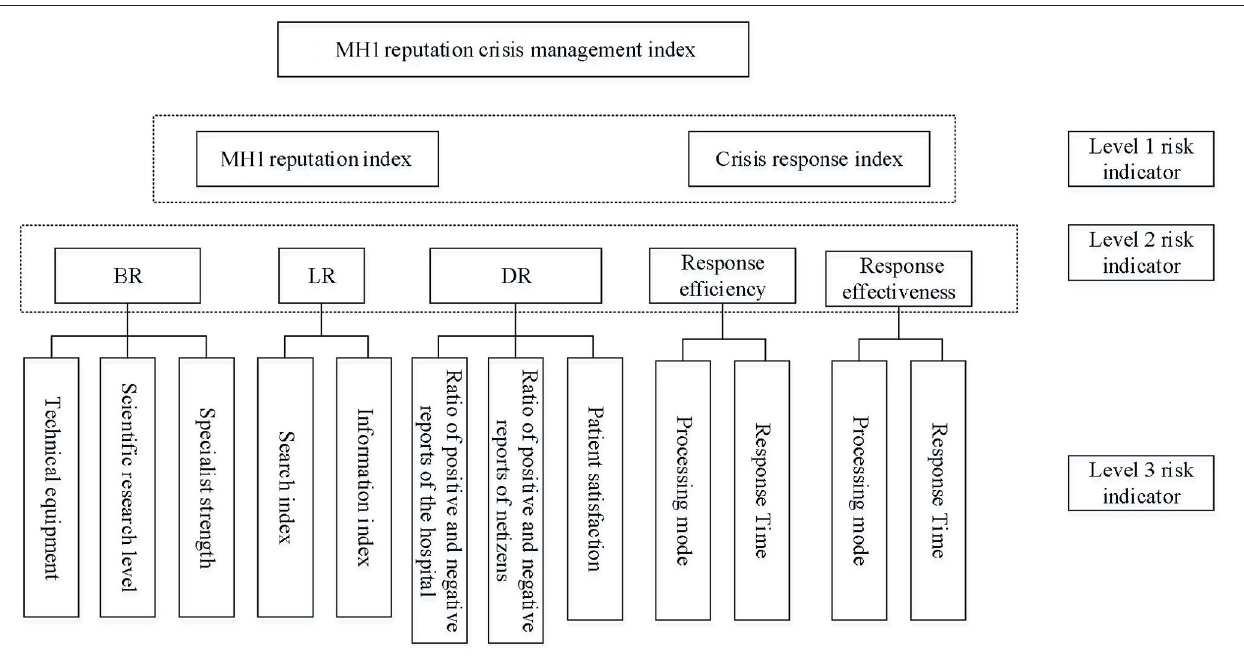
FIGURE 1 | Architecture diagram of MHI reputation crisis management index.